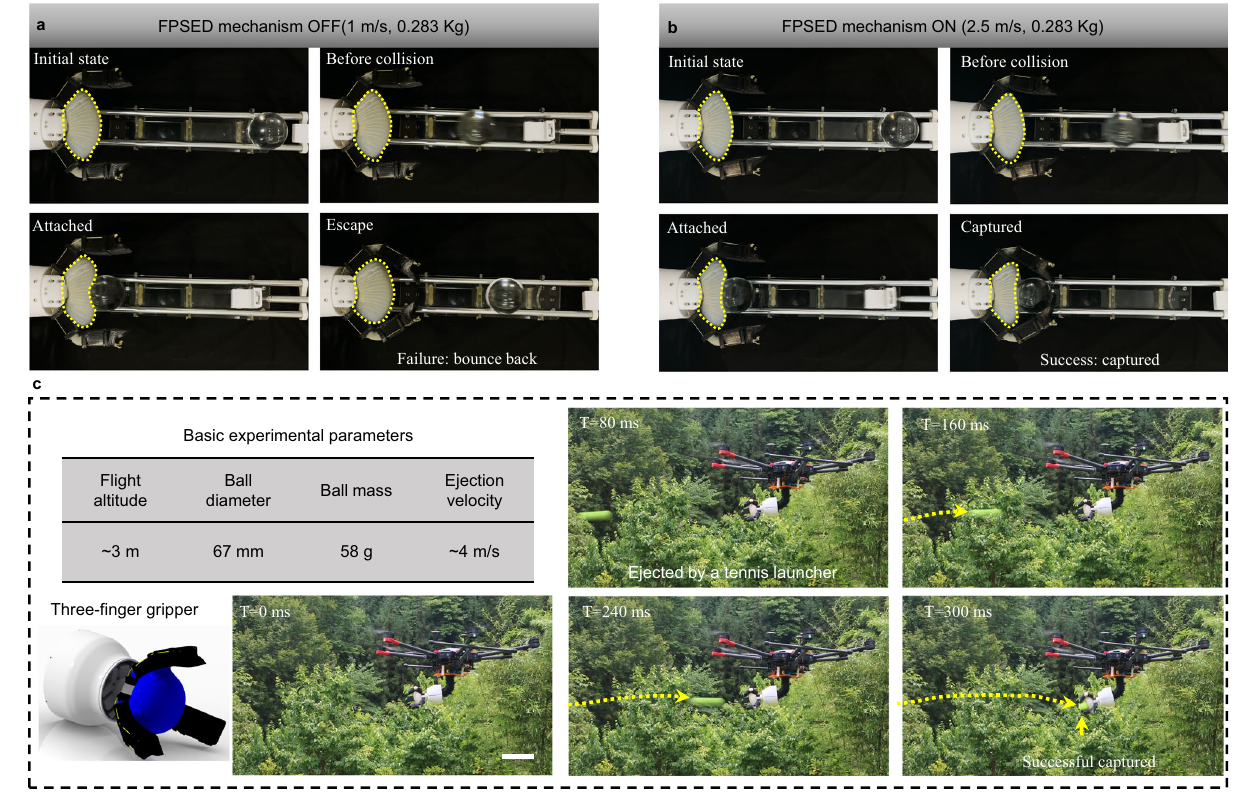
c Demonstrationofa six-rotordrone equippedwitha three- fi ngersoftgripper to capture dynamic targets in an outdoor environment. A launcher ejects the tennis ballasatarget,andithasamassof58g,adiameterof67mm,andaspeedof~4m/ s. Scale bars represent